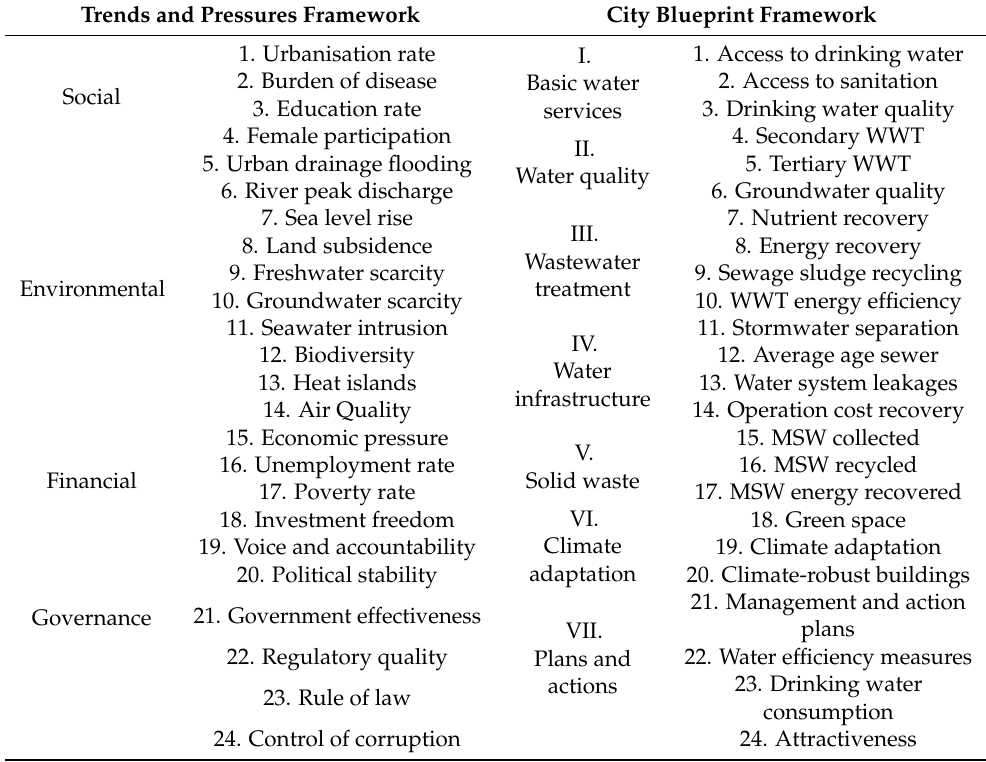
Table 1. Indicators and categories of TPF (left) and CBF (right). Trends and Pressures